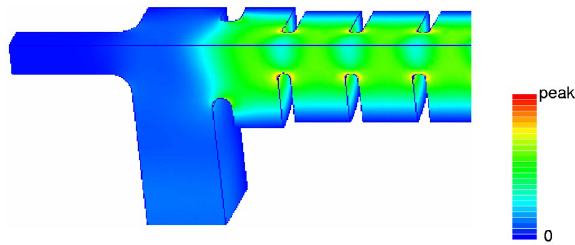
FIG. 6. (Color) Quarter geometry of an accelerating waveguide coupler with electric field plot. The fields in the waveguide region are raised to provide significant acceleration.